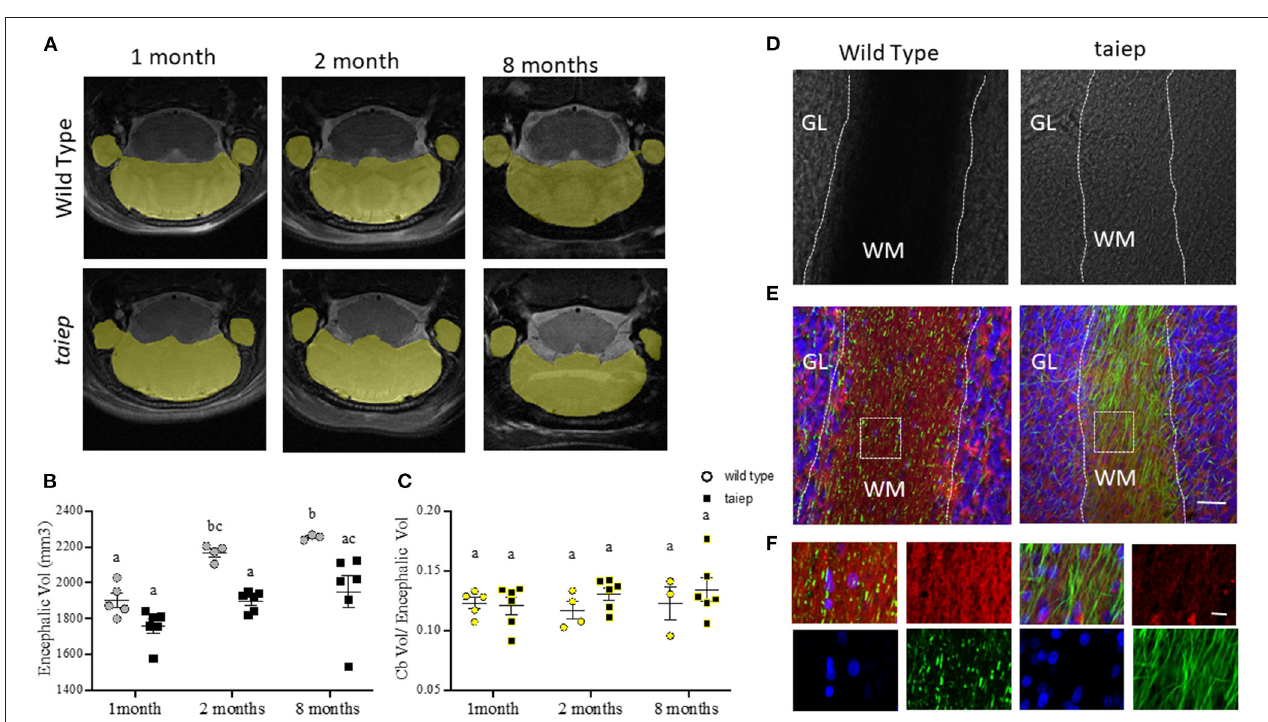
FIGURE 5 | Anatomical and histological analysis of cerebellum in taiep rat at different stages of development. Representative images of T2-weighted coronal sections illustrating individual masks in cerebellum (yellow) at 1, 2, and 8 months (A) . Scatter plot of the values of encephalic volume. WT encephalon volume was significantly bigger than that of taiep rats at 2 and 8 months (B) . Non-significant differences were obtained for volume ratio cerebellum/encephalon of WT and taiep rats along the analyzed periods (C) . The data obtained for each rat are represented by one point in the plot (at least n = 3 for group). Two-way ANOVA followed by Tukey’s multiple comparison test was performed. Different letters indicate significant differences between groups (B,C) . Bright-field micrographs of coronal slices of cerebellum of WT and taiep rat brains (10 months) (D) . White dotted lines delimitate the white matter region in cerebellar folia. Myelin (red) and neurofilament (green) were revealed by immunofluorescence (E,F) . An enlarged view of the white squares for merge and separated channels is shown in (F) . Nuclei were revealed by DAPI (blue). Scale bars: 30 µ m (E) and 10 µ m (F) . GL, granular layer; WM, white matter.